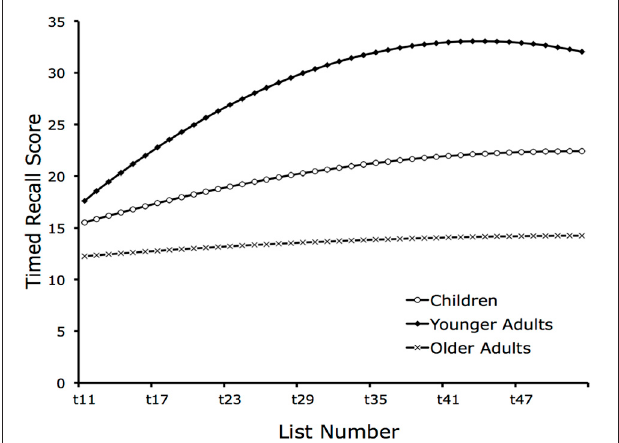
FIGURE 6 | Practice gains. Mean performance (Timed Recall Score) during the practice phase as predicted from the parameter estimates of the intercept, linear slope, and quadratic slope as a function of list number and age